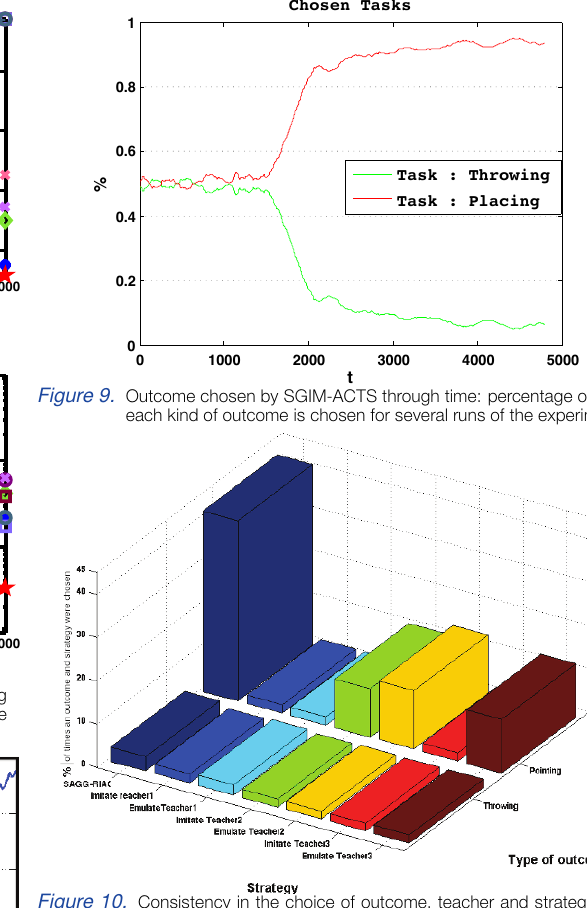
Figure 10. Consistency in the choice of outcome, teacher and strategy: per- centage of times each strategy, teacher and outcome are chosen over all the history of the